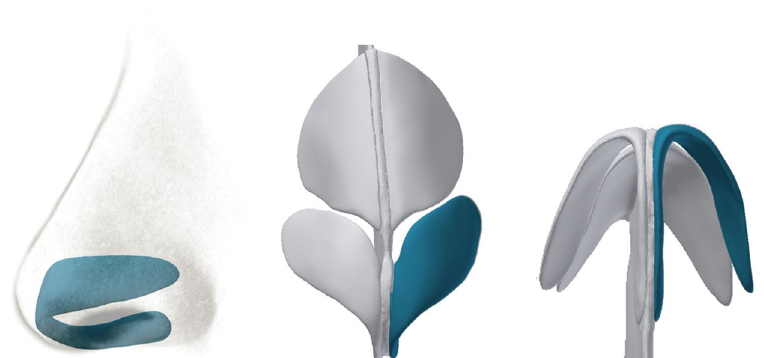
Figure 1. Illustration of the cartilaginous structure of the nose, with specific focus on the alar cartilages (also known as Lower Later Cartilages), shown in blue. Left: lateral view, with illustration of the cartilage position within the nose. Centre: Anterior view of the cartilaginous structure of the nose captured using computed tomography. Right: Inferior view demonstrating the curvature of the alar